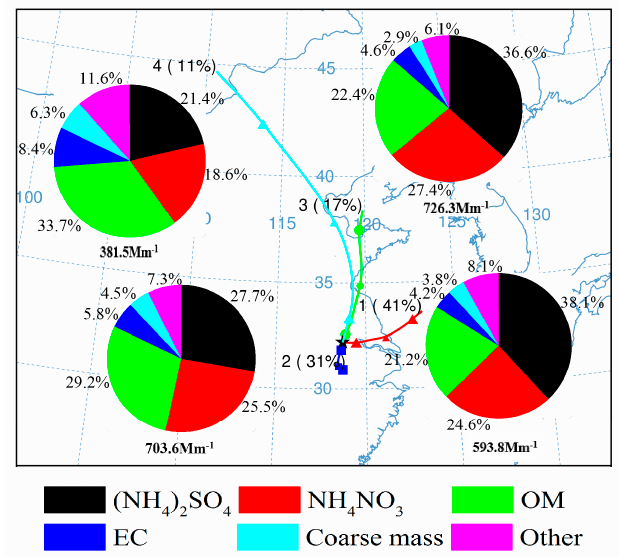
Figure 8. Relative contributions of different components to the light extinction from different air masses.